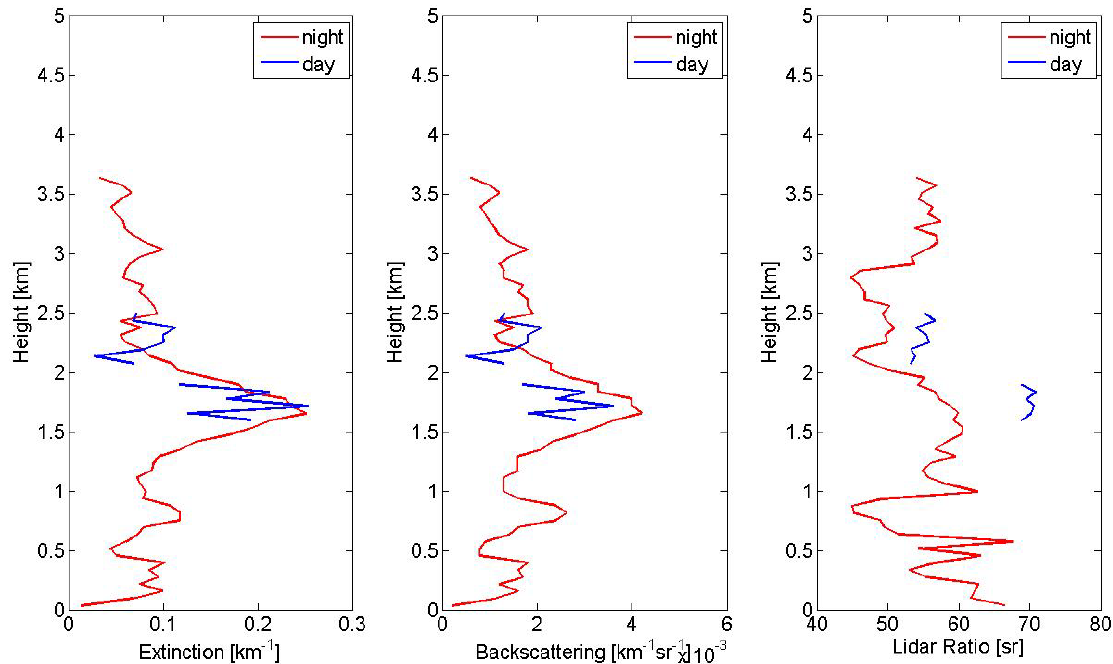
Figure 7. The average extinction, backscattering, and lidar ratio profiles on 30 July 2010. Nighttime measurements (at 1:11 a.m. UTC) in red, and daytime measurements (at 10:53 a.m. UTC) in blue. The measurements were done between latitudes 67.0 and